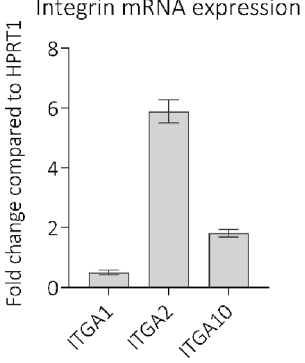
Figure 1. qPCR quantification of relative mRNA expression levels of each integrin, in HUVECs, compared to the endogenous control (HPRT1) using the ∆CT method. ITGA1, ITGA2 and ITGA10 indicate the transcripts that code for the integrin α1, α2 and α10.subunit respectively. For ITGA1, ITGA2 and ITGA10 n = 11. Error bars indicate SEM calculated from all